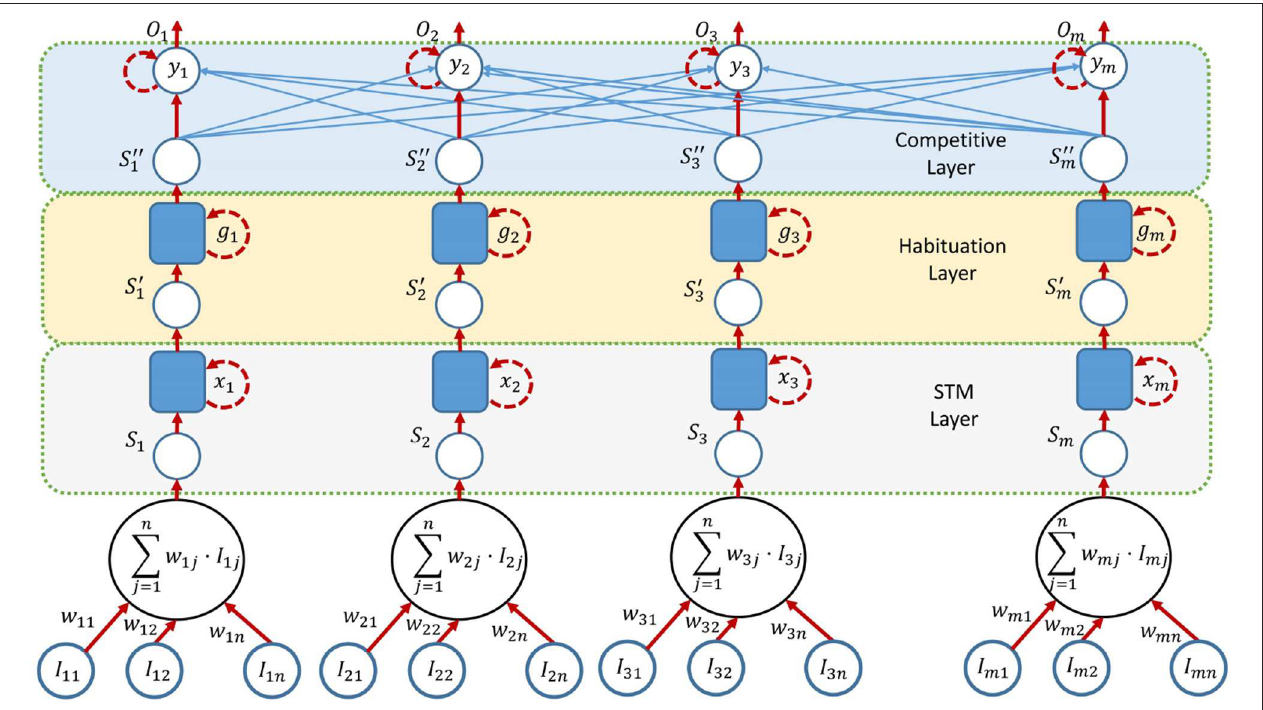
FIGURE 5 | Architecture of the competitive